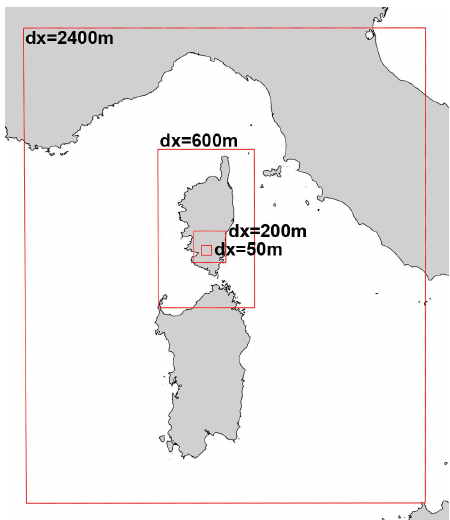
Figure 2. Overview of the nested Meso-NH